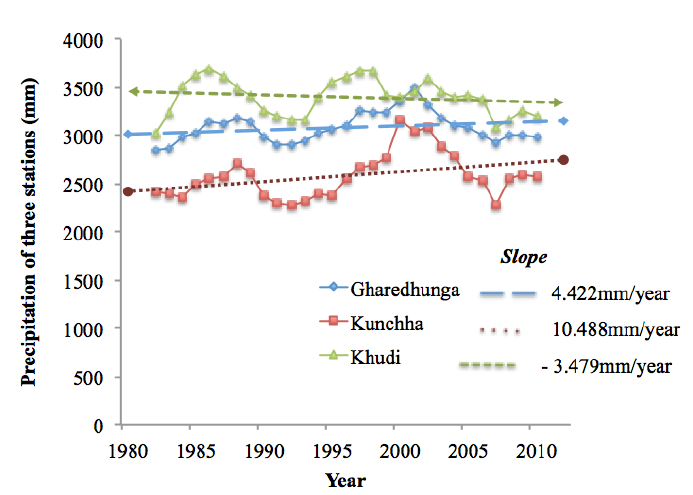
Figure 2. Annual precipitation trends at the Gharedhunga, Kunchha and Khudi stations from 1980 to 2012.